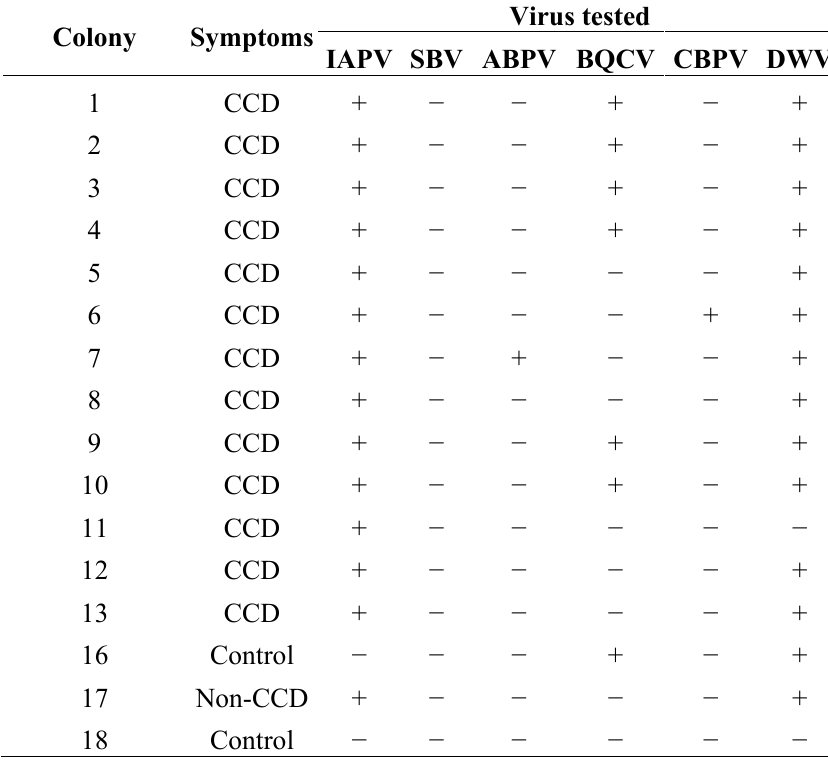
Table 1. Viral incidence in colonies exhibiting CCD-like syndrome. Viruses detected in RNA extracted from a pool of 10 adult bees. “+ and −, positive- and negative-virus samples, respectively”. IAPV-positive samples were confirmed with a second pair of primers as described in Material and